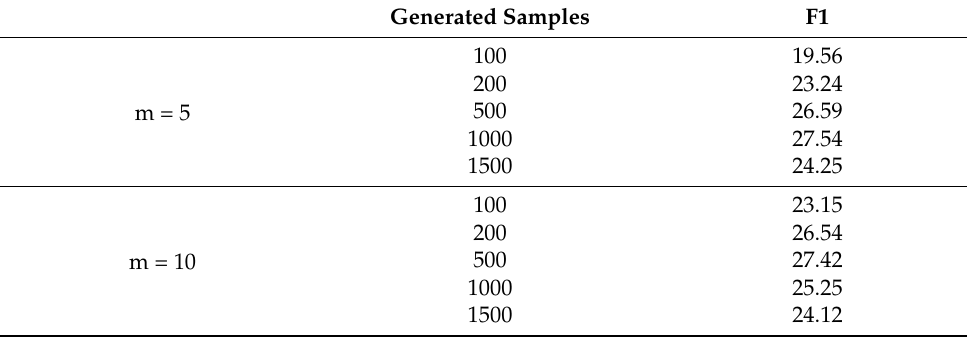
Table 9. Effect of Uyghur generated data size On